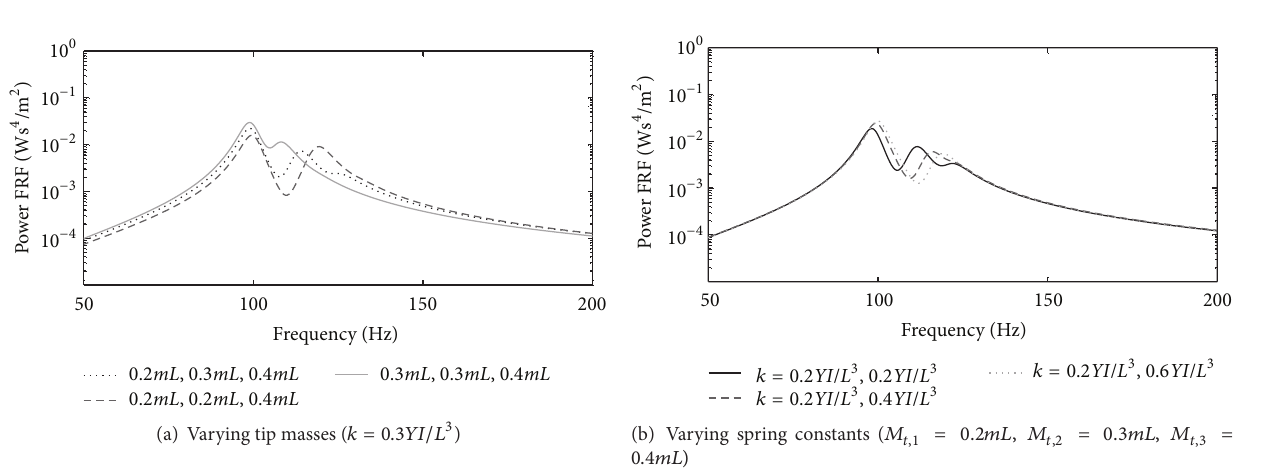
associated with each resonant frequency depend on